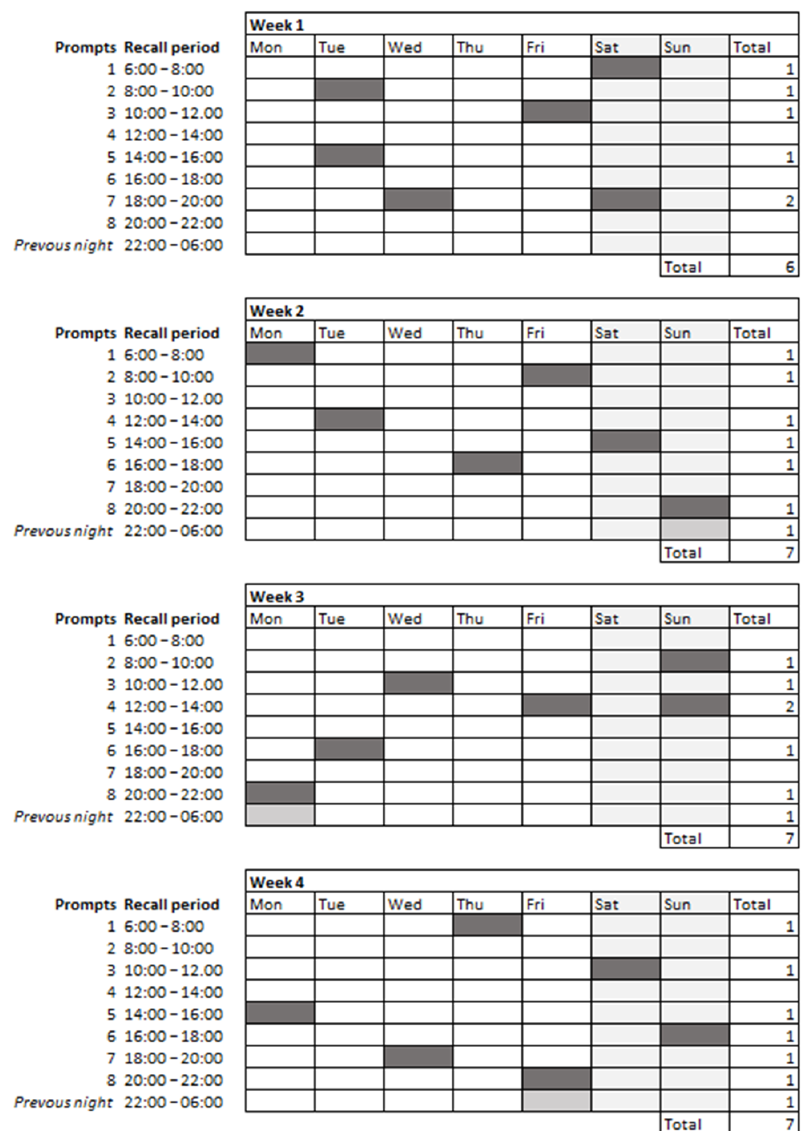
Figure 3. Example habitual intake sampling scheme (i.e., three times each